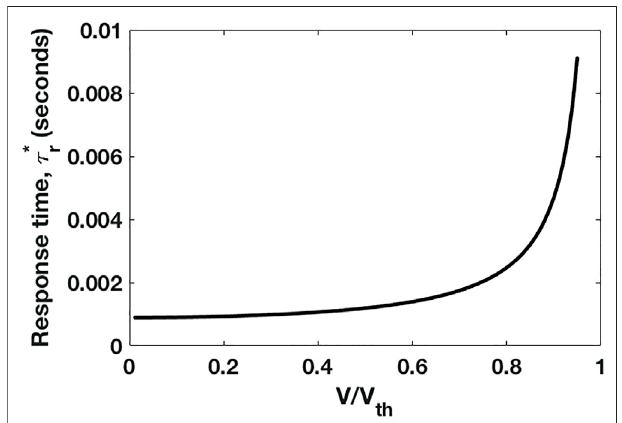
FIGURE 7 | Response time τ r ′ as a function of V / V th